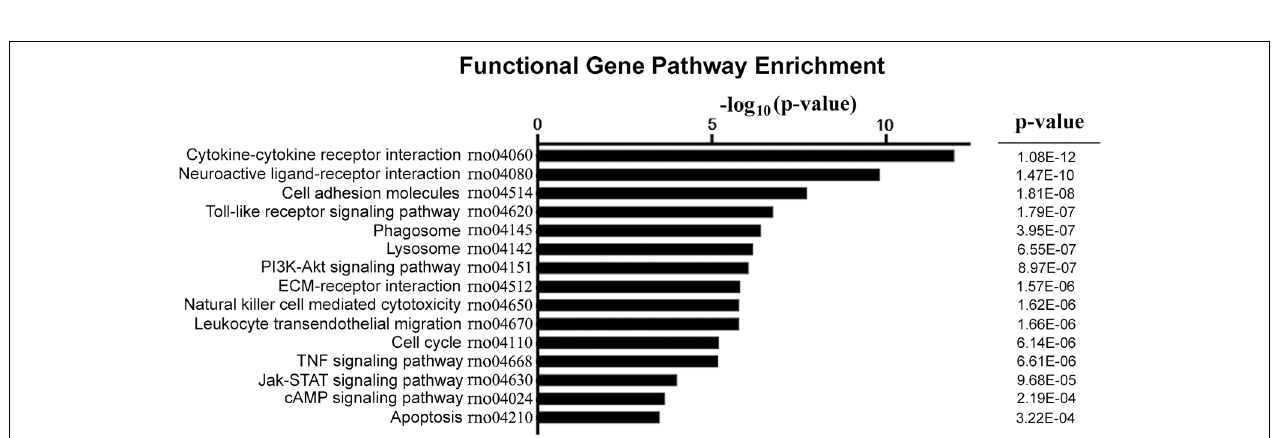
FIGURE 4 | KEGG pathway enrichment analysis for DEGs. The vertical axis on the left side represents the name of the pathway, and the horizontal axis at the top represents the value of − log 10 ( p -value). P -value was adjusted by FDR. KEGG, Kyoto Encyclopedia of Genes and